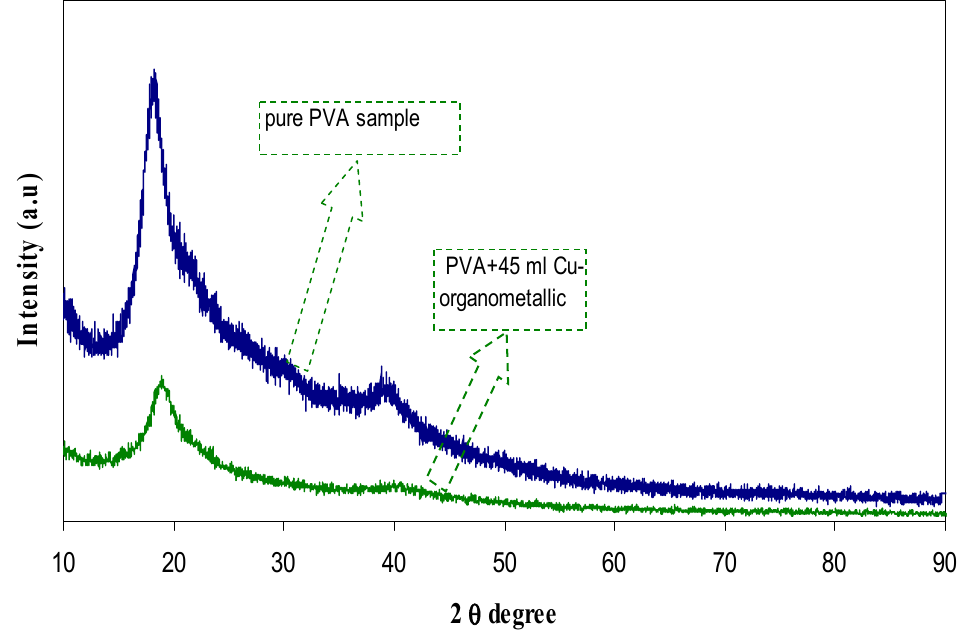
Figure 4. XRD pattern for pure PVA and PVA doped with 45 mL organocopper (PVORG3).